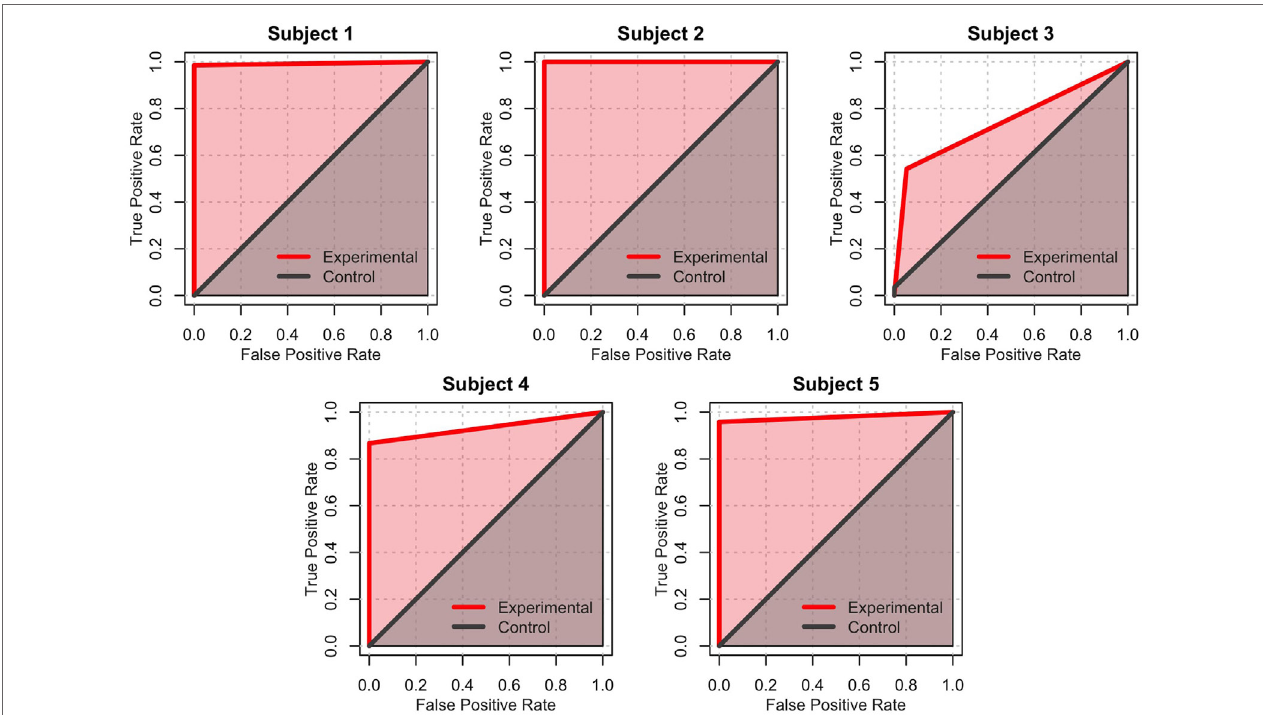
FigUre 8 | receiver operating characteristics (rOc) for the control games (gray) and experimental games (red) . A perfect classifier (100% true positives and 0% false positives) occupies the upper-leftmost corner of the graph. In contrast, a random classifier is represented by a straight line across the diagonal. The experimental condition of Subject 2 is an example of a perfect classifier, while the control condition of Subject 2 exemplifies a random classifier.